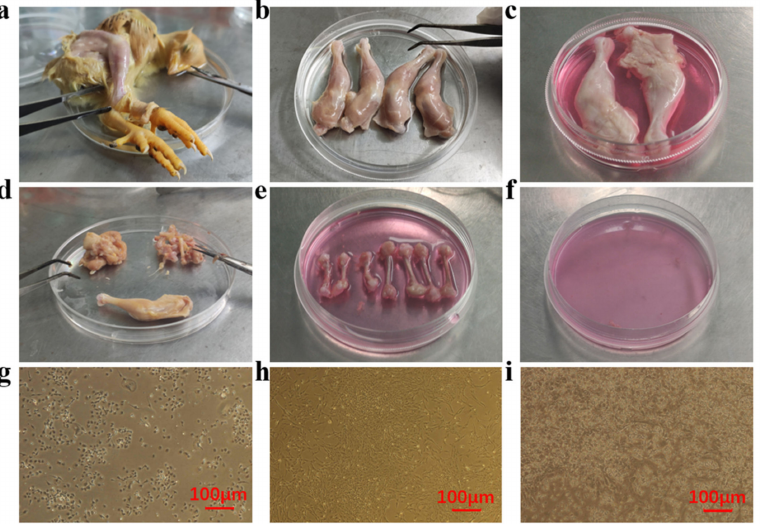
Figure 2. Isolation of chicken BM-MSCs. ( a ) The chicken was soaked in 75% alcohol to dissect legs and then ( b ) soaked the legs in 75% alcohol and ( c ) serum-free DMEM sequentially. ( d ) Removing muscles and connective tissues stuck to femurs and tibia. ( e ) Femurs and tibia were soaked in serum-free DMEM and cut off both sides of the epiphysis to expose the bone marrow cavity. ( f ) The bone marrow cavity was flushed by serum-free DMEM to collect cells. Finally, a differential adhesion method was performed to purify BM-MSCs. The length of the first differential adhesion time affected the purity of BM-MSCs. Morphological observations showed that ( g ) 2 h differential adhesion did not collect enough BM-MSCs; ( h ) 4 h differential adhesion collected enough BM-MSCs; ( i ) 24 h differential adhesion resulted in low cell purity of